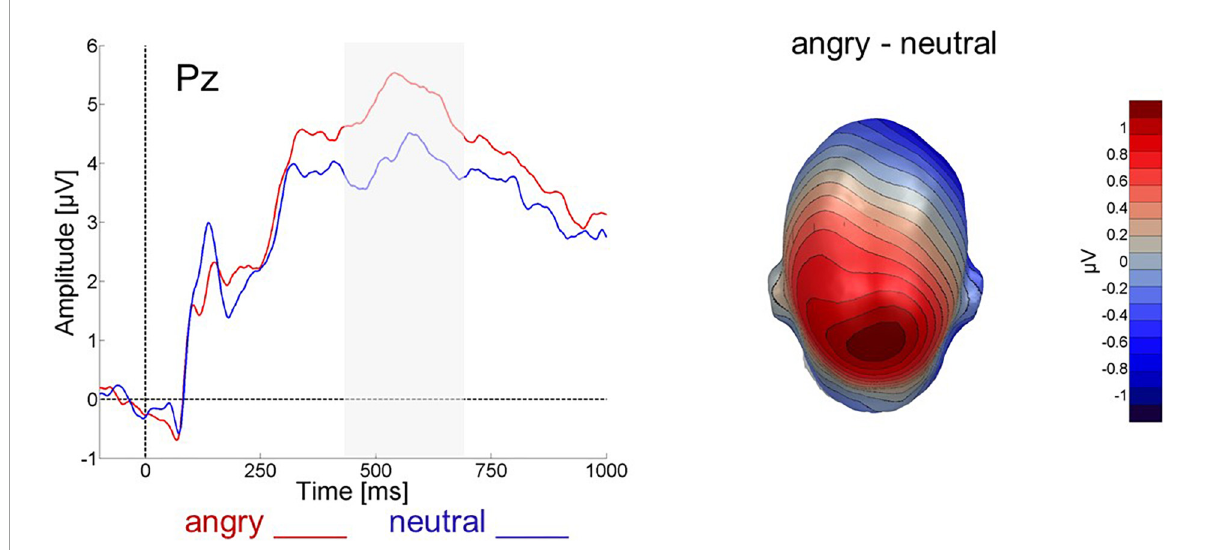
FIGURE3 Face-evoked ERP for angry (red) and neutral (blue) faces at electrode Pz and difference topography for angry minus neutral faces across all 64 electrodes between 450 and 700 ms after face onset.